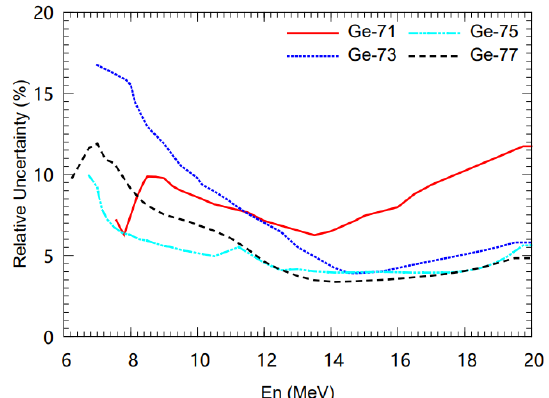
Fig.8. The comparison of evaluated 95 Zr(n,2n) cross sections and uncertainties in ENDF/B-VIII.0, JEFF-3.3 and CENDL-3.2.